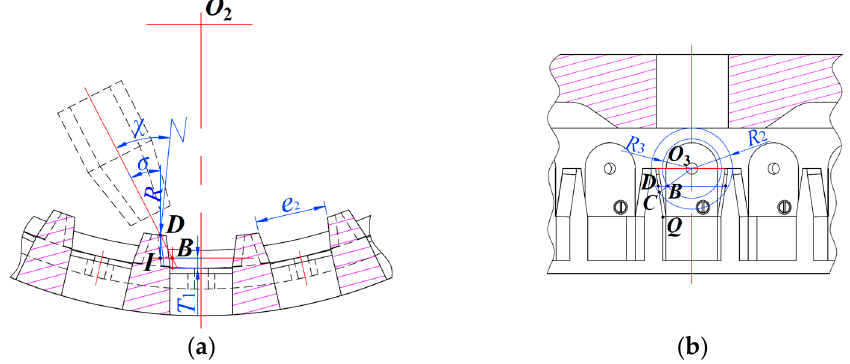
Figure 8. Design of the inclination angle of the central axis of the outlet section of the seed-disturbing air nozzle: ( a ) front view and ( b ) top view. Note: C , intersection of the outer circle and the outermost edge of the sidewall of the type hole; B , intersection of the straight line CO 3 and the inner circle; D , intersection of a plane passing through point B and perpendicular to the central axis of the seeding plate with the outermost edge of the sidewall of the type hole; Q , highest point of the sidewall of the end surface of the filling hole; T 1 , distance between the gravity center of cotton seed and the lower bottom surface of corresponding type hole, mm; e 2 , width of the upper bottom edge of end surface of the filling hole, mm; R 2 , outer circle radius, mm; R 3 , inner circle radius, mm; σ , angle of air nozzle’s axis with the symmetry plane of the corresponding type hole, ( ◦ ); and χ , angle between the line connecting the seeding plate center point and the intersection of air nozzle’s axis and the outermost edge of the sidewall of the type hole and the air nozzle’s axis in the plane passing through the air nozzle’s axis and perpendicular to the central axis of the seeding plate, ( ◦